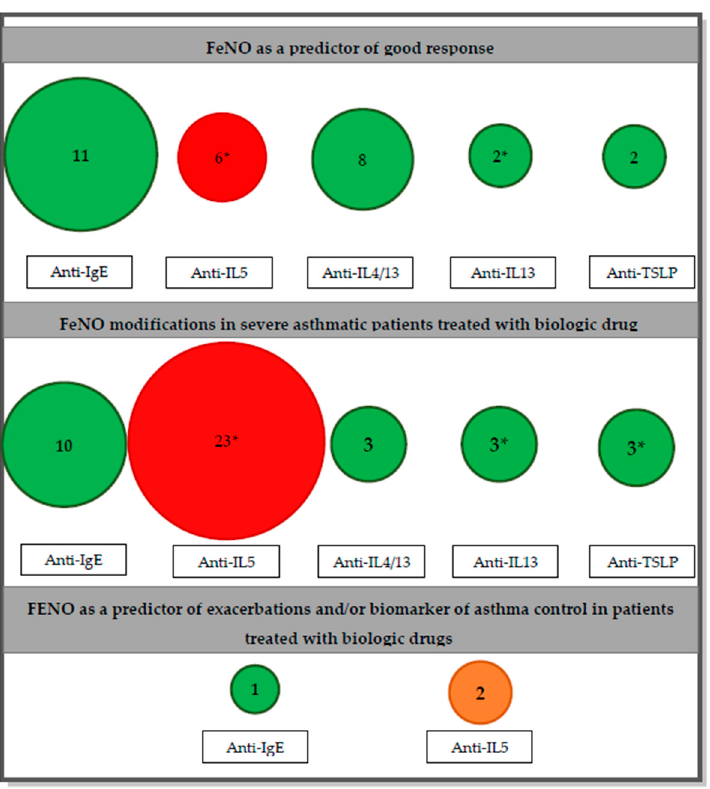
Figure 2. The size of the circles and the number inside reflect the number of articles reviewed per drug. The color reflects the agreement of the results with the points in examination (Green = concordance; Red = discordance; Orange = no diriment data). *: presence of RCT between the study reviewed.